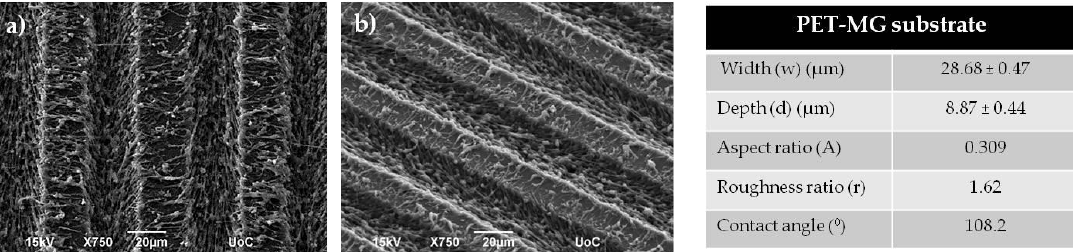
Figure 1. Scanning electron microscopy (SEM) images (top ( a ) and tilted ( b ) view) of polyethylene terephthalate microgroove (PET-MG) substrates. Measurements of the geometrical parameters of the surface of the PET-MG substrates in the tilted view of the SEM images were processed by Fiji ImageJ. A series of measurements were obtained for the surface characterization, such as width (w) and depth (d) of microgrooves, aspect ratio (A = d/w) and roughness ratio (r = 1 + 2d/w). Measurements of the contact angles were performed with the use of a tensiometer.